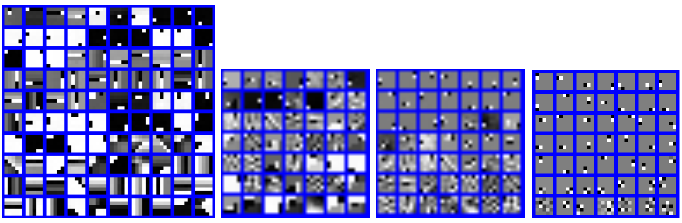
Figure 4. The exemplified dictionaries training by the piecewise constant. From left to right: Synthesis KSVD (25 × 100), our proposed dictionary pair (25 × 50) and analysis KSVD (25 ×